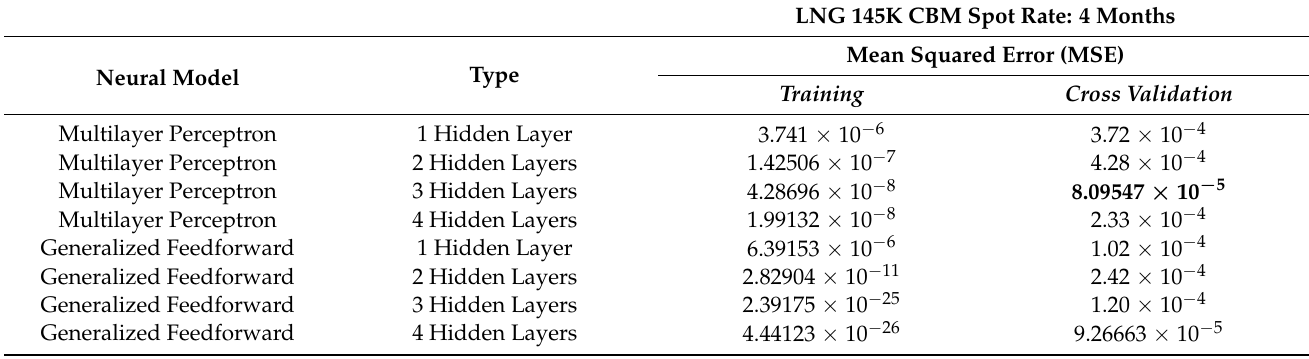
Table 8. Results of forecast for LNG 145K CBM spot rate: 4 months. The best score is shown in